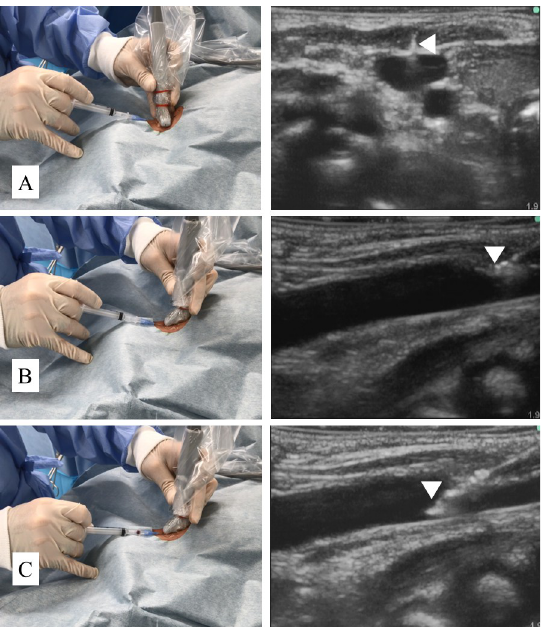
Fig 2. Combined short-axis out-of-plane and long-axis in-plane approach. (A) The needle tip (arrowhead) is visualized as a white dot on the midline axis of the vein in the short-axis view. (B) After rotating the transducer by 90˚, the entire length of the needle, including the needle tip (arrowhead) and the vein, are visualized in the long-axis view. (C) The needle tip (arrowhead) is visualized penetrating the anterior wall of the vein.